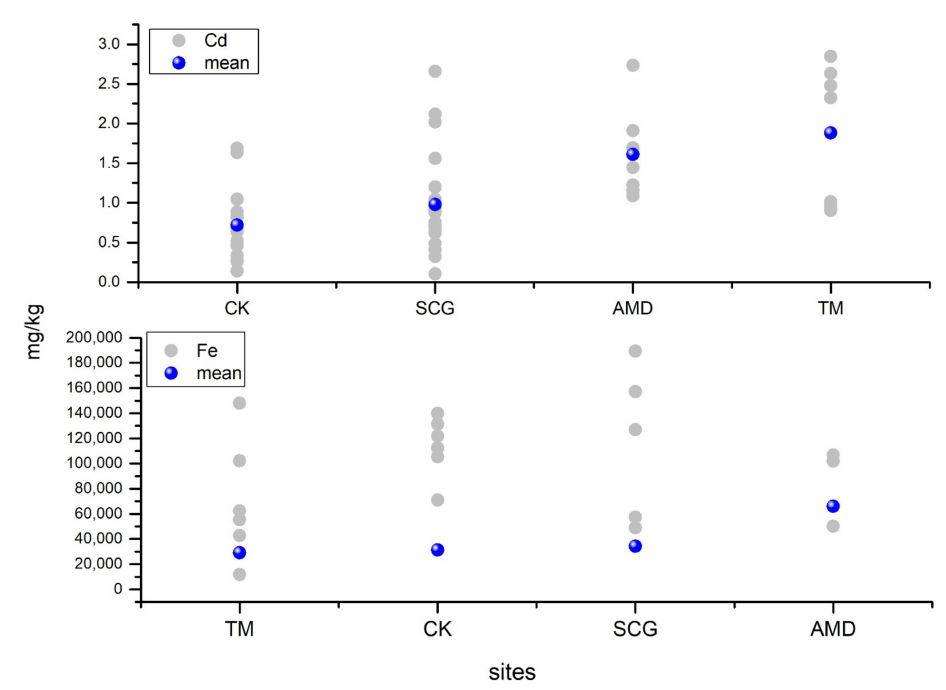
Figure 4. The concentrations of Cd and Fe in the soil from different sites in Youyu